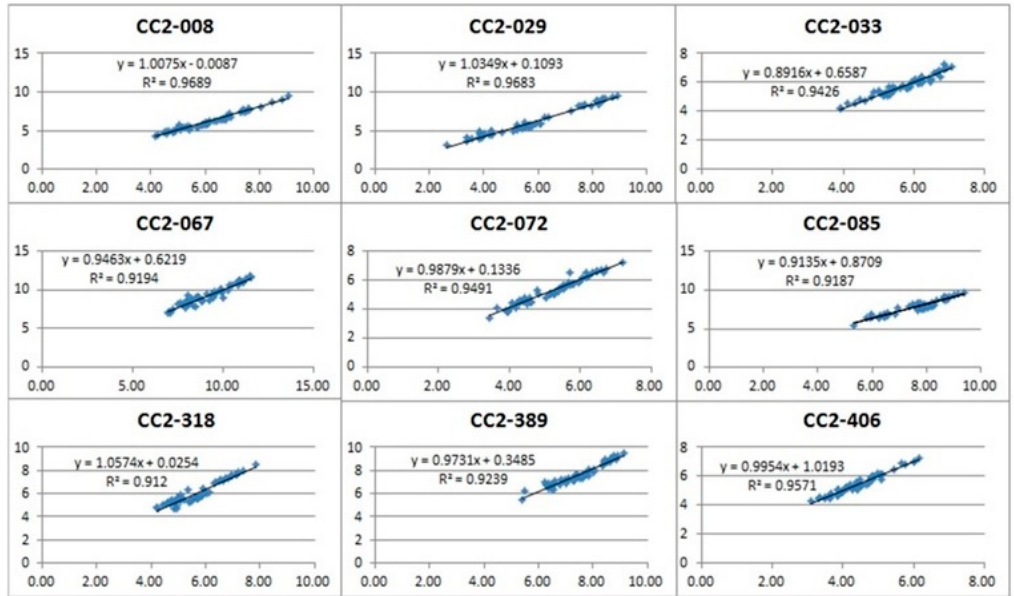
Figure 8. Correlation between actual measurement and image measurement of randomly selected 9 lines.